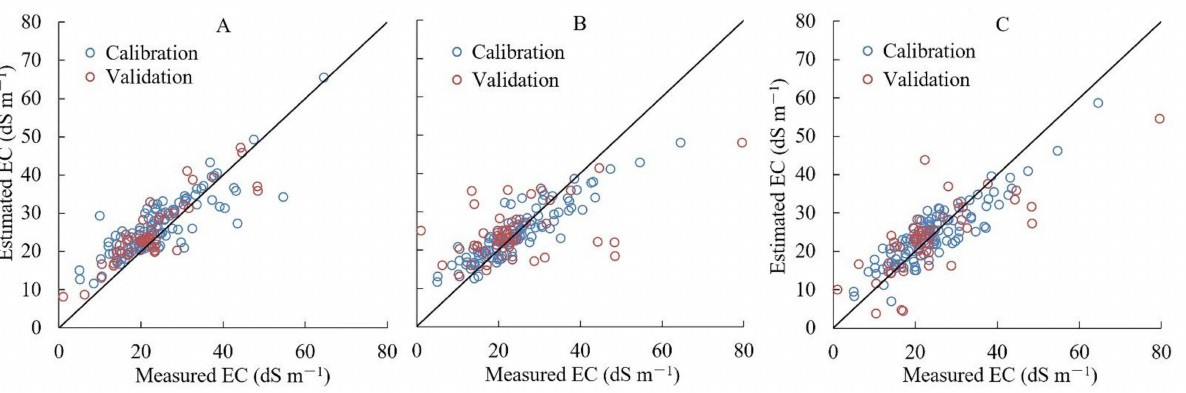
Figure 5. Scatter plots of the measured and estimated soil EC values derived from the SVM, RF, and ANN regression models using the Sentinel-2 MSI data. ( A ) SVM model, ( B ) RF model, ( C ) ANN model. The black solid line represents the line where the ratio of the measured values to the estimated values is